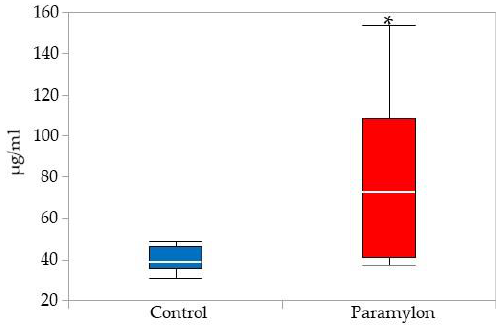
Figure 2. Serum sIgA concentrations. * Significantly different from the control group (Mann-Whitney test, p < 0.05).